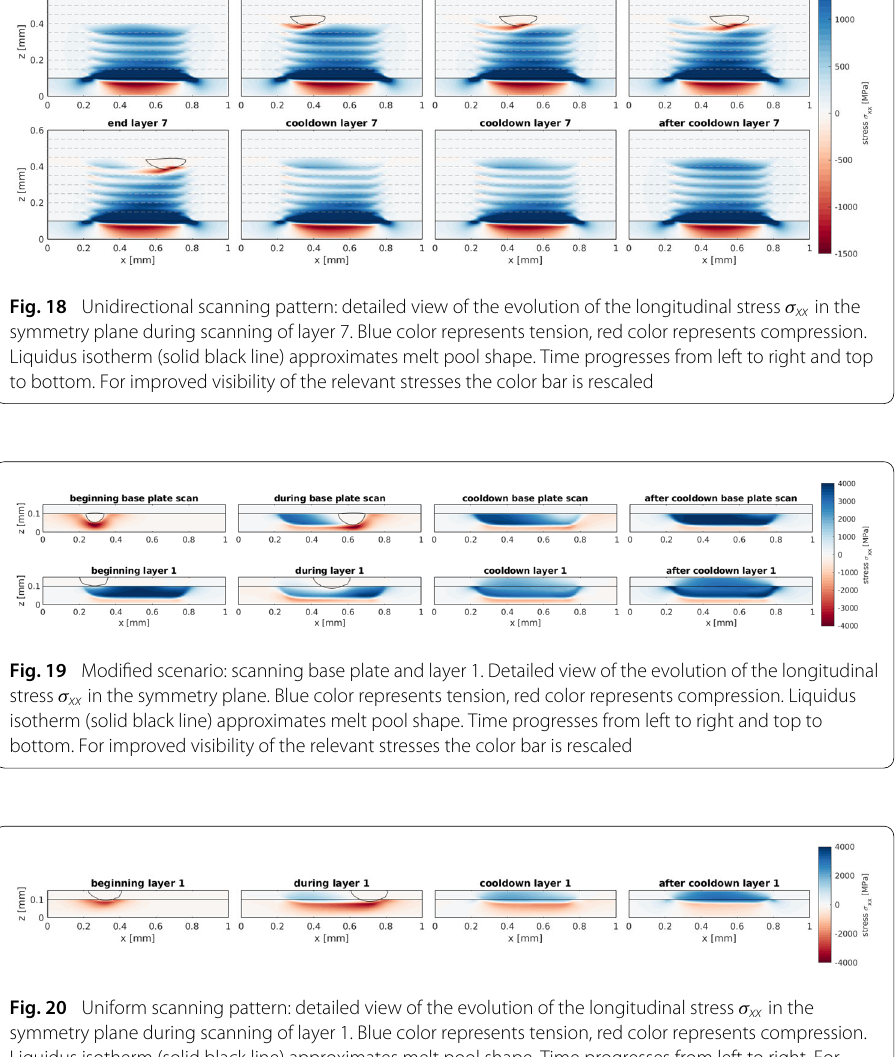
(top right in Fig. 19). The subsequent processing of layer 1, using a unidirectional pattern, leads to remelting in the uppermost region of the base plate, which causes a reduction of the tensile stress after the next cooldown phase. The strong gradient between tensile and compressive stresses, which was observed close to the interface between base plate and layer 1 in Fig. 18, shifts down in Fig. 19 while the magnitude stays roughly the same. For comparison, Fig. 20 shows a detailed view of the evolution of stress σ xx when the first layer is scanned atop a stress-free (not scanned) base plate, i.e., the scenario that was initially investigated in this section. The stress distribution in layer 1 after cooldown for this case (right-most plot in Fig. 20) is equal to the stress distribution in layer 1 after cooldown with a pre-processed base plate (bottom right in Fig. 19), which demonstrates that the chosen pre-processing of the base plate does not influence the stress in layer